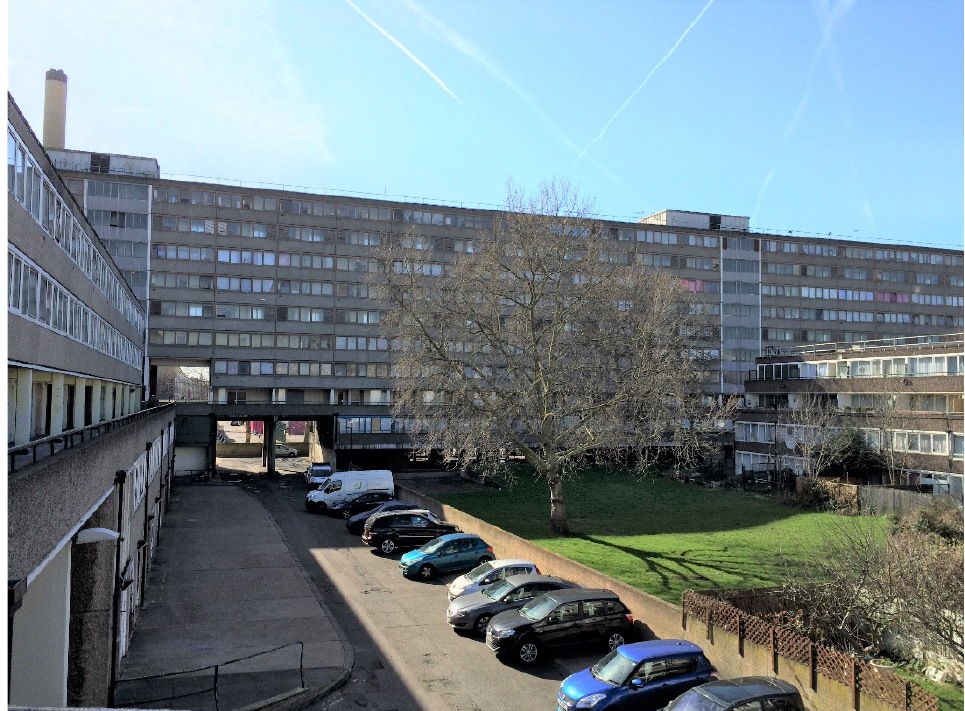
Figure 1. Aylesbury estate, 2017. Source: Paul